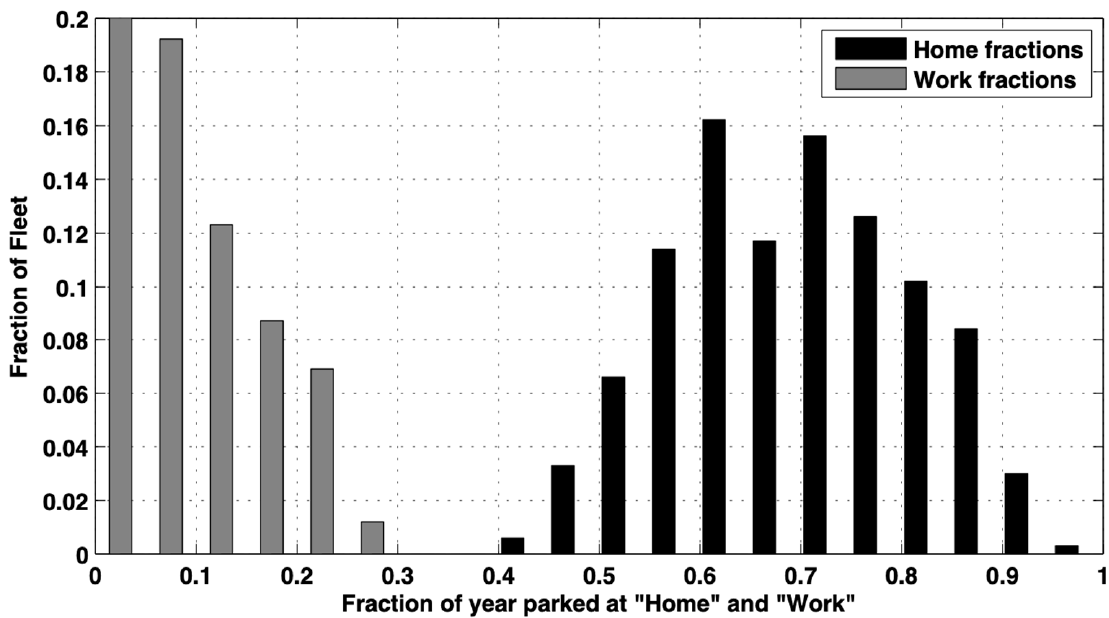
Figure 1. Distribution of time at Work (grey bars) and time at Home (black). The X-axis gives fractions of time over the year, so 0.1 means 10% of the time over the year. The leftmost bar is truncated; its actual height is 0.52. Reprinted by permission, from Pearre [24].